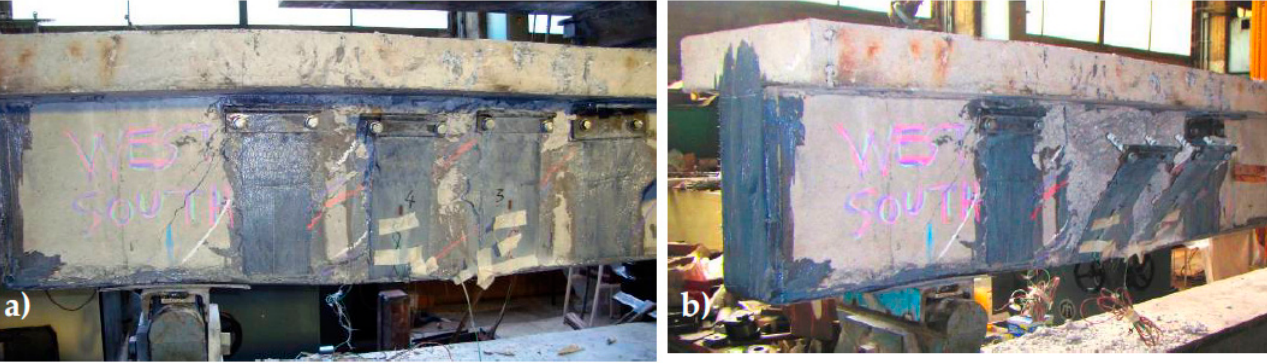
Figure 23. ( a ) The 3rd st rengthening scheme (West part). ( b ) The widening of the shear diagonal cracks and the partial crushing of the concrete volume in the anchoring region reduced considerably the effectiveness of this anchoring scheme.